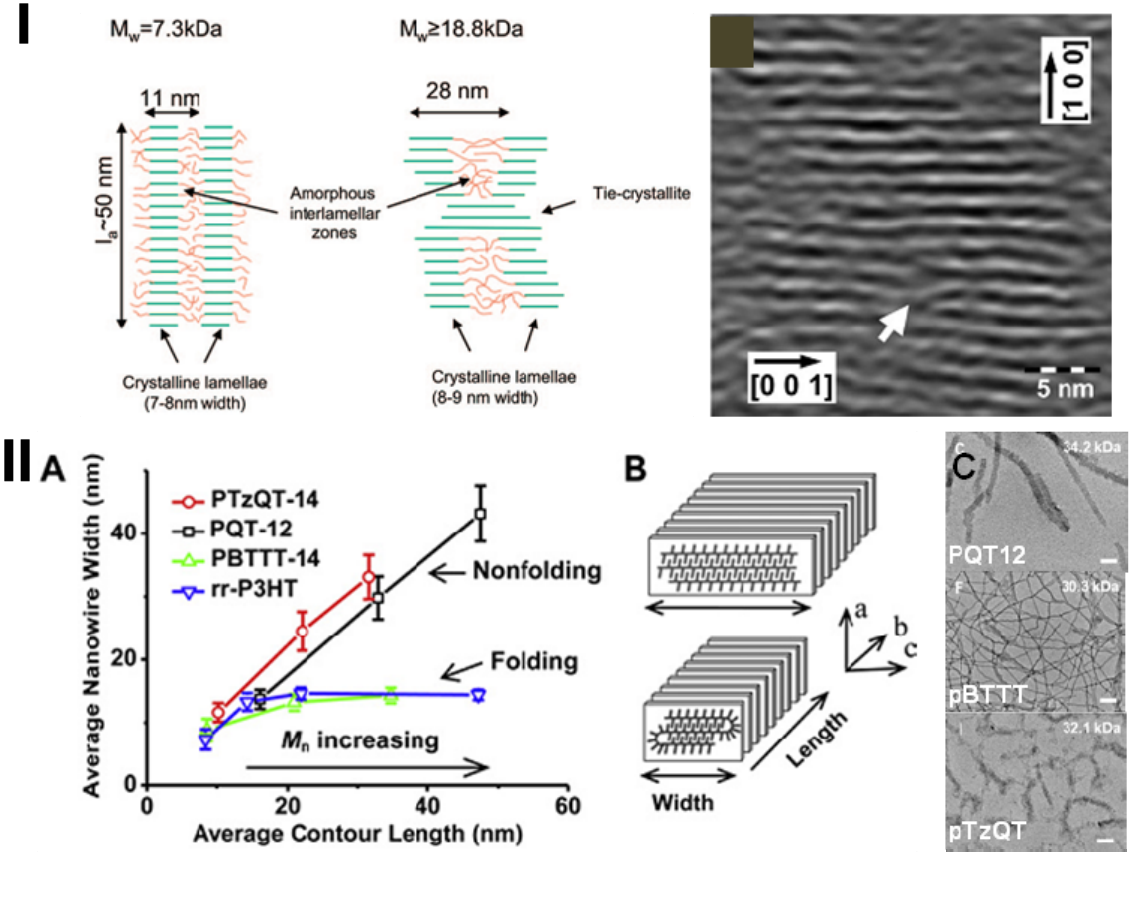
Figure 6. ( I ) Schematic representation of the microstructure size in semicrystalline Rr-P3HT of different molecular weights influenced by chain-bendings and the HR-TEM photos for bendings indicated by the arrow, (Adapted with permission from [71]. Copyright 2009 American Chemical Society); ( II ) Dependence of average nanowire width on average contour length of PQT-12, PBTTT-14, PTzQT-14, and rr-P3HT in ( A ) and simplified cartoons illustrating the difference between conjugated polymer nanowires with folding ( bottom ) and nonfolding ( top ) chains in ( B ) and TEM photos for nanowires of PQT12, pBTTT and pTzQT with similar high molecular weights in ( C ), (Adapted with permission from [72]. Copyright 2011